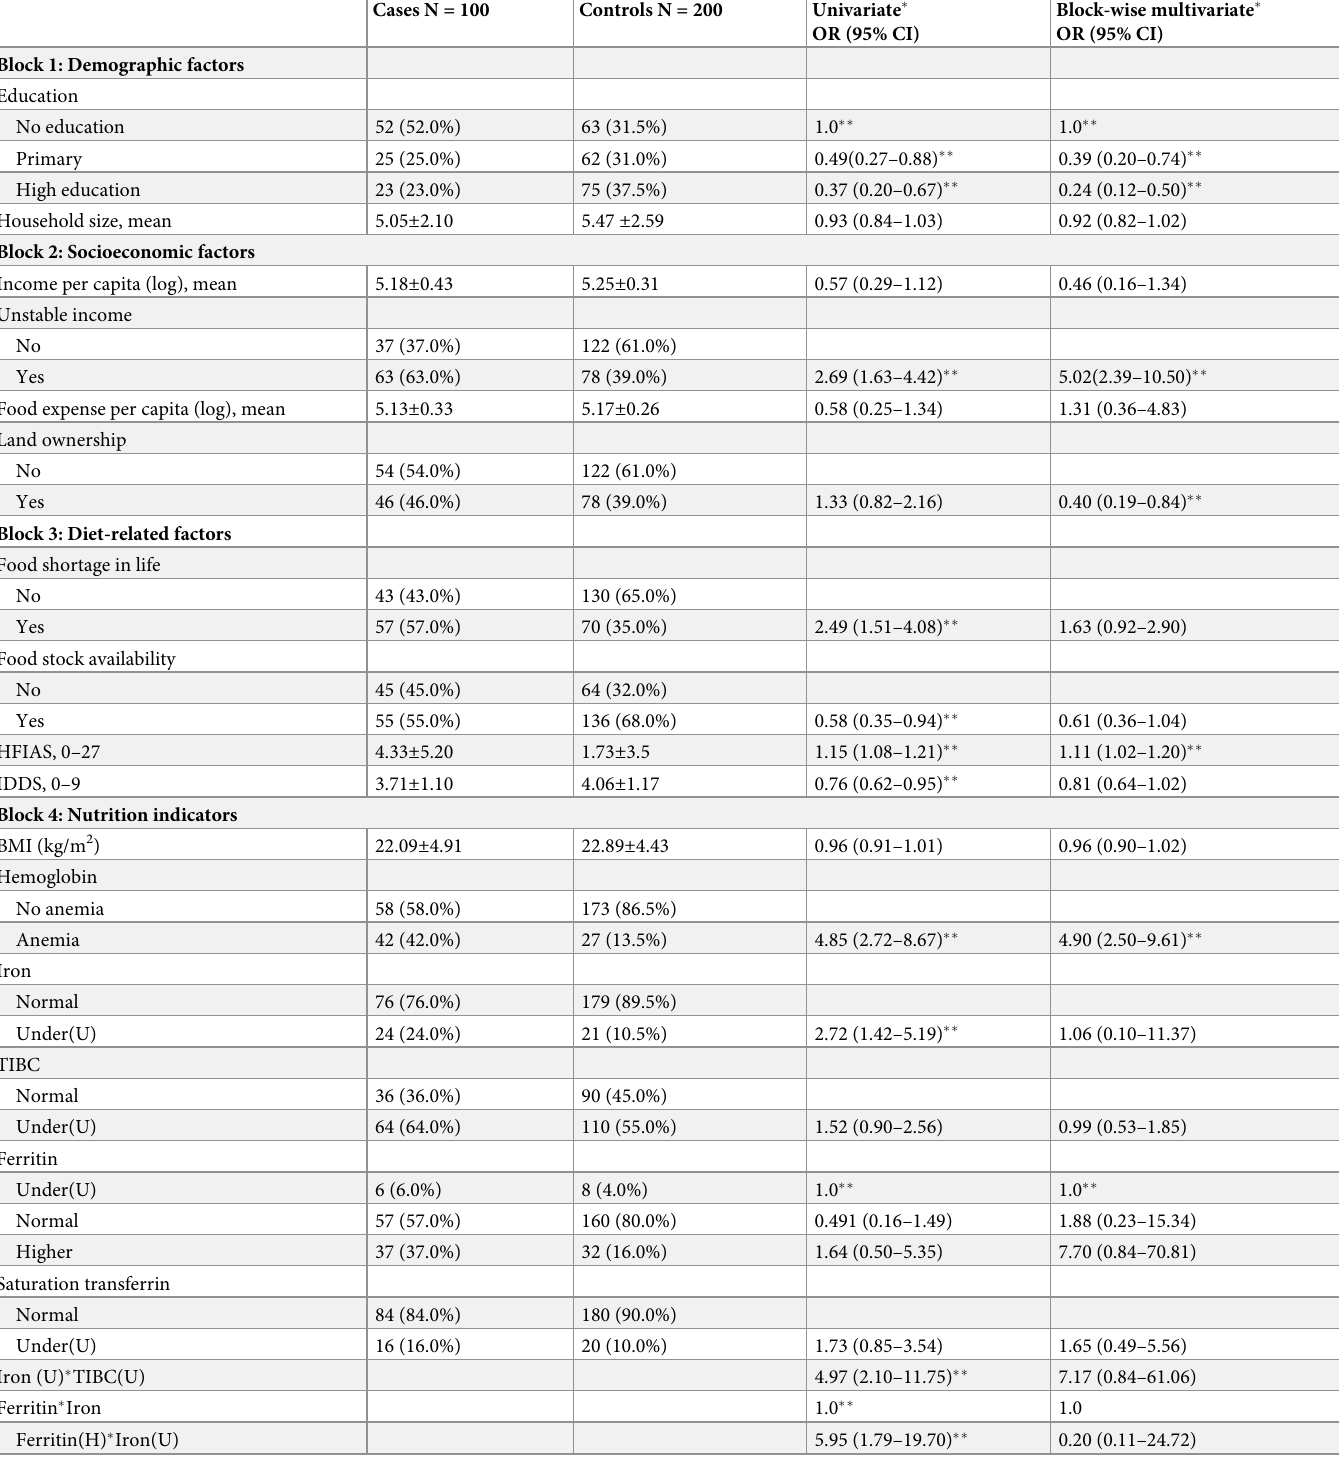
Table 4. Block-wise univariate and multivariate logistic regression